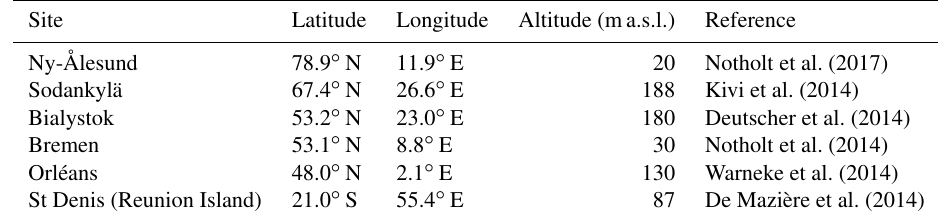
Table 1. The coordinates and the altitudes (ma.s.l.) of the TCCON FTS sites used in this study.